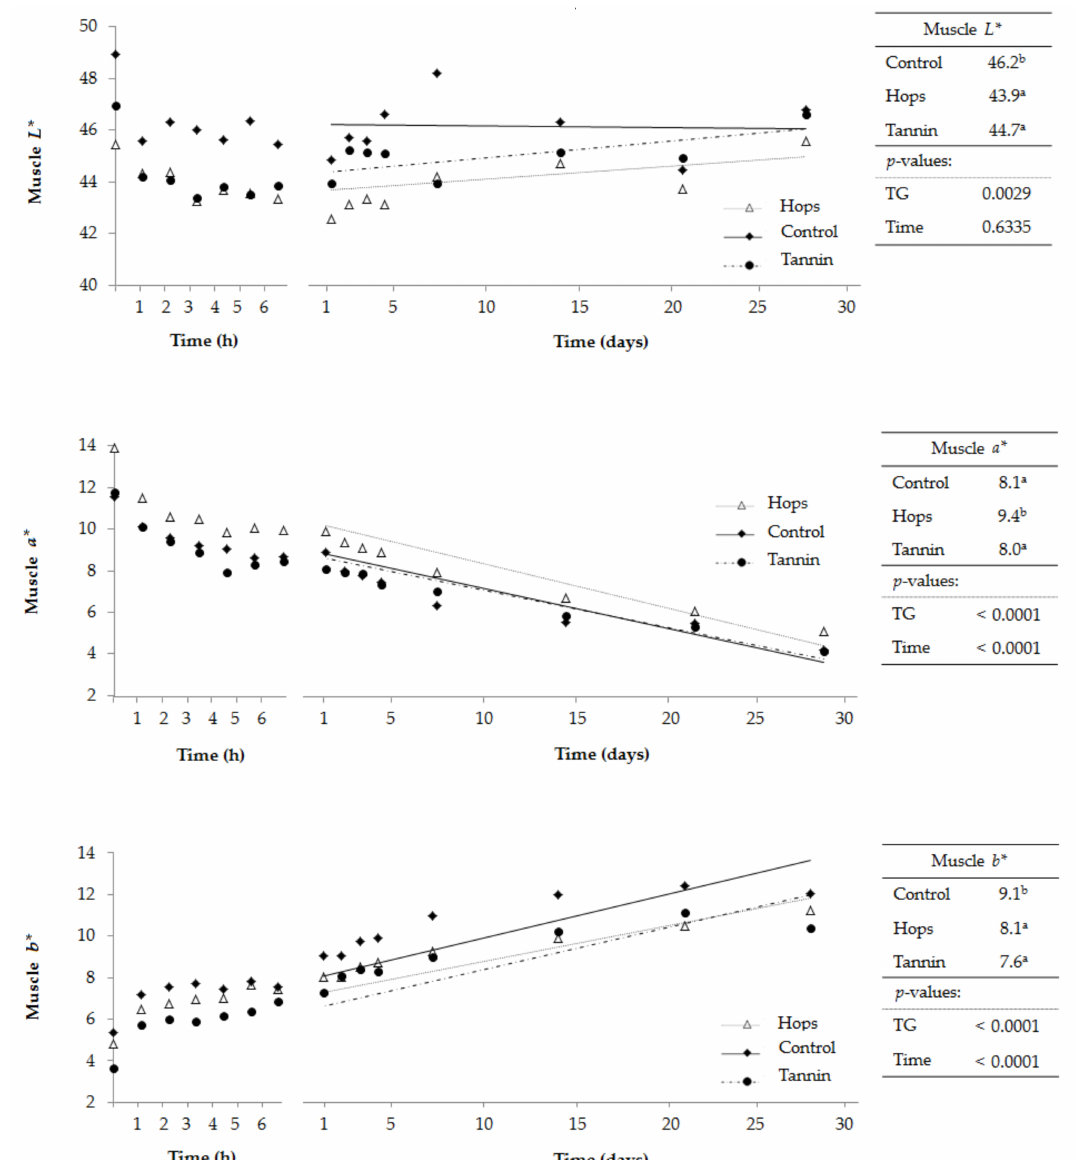
Figure 3. Objective color parameters: CIE lightness: L *, redness: a *, and yellowness: b * of muscle of dry-cured bellies during refrigerated storage with lsmeans and p -values for treatment group (TG) and time effects ( abc intercepts ascribed different superscript letters are significantly different at p -value <